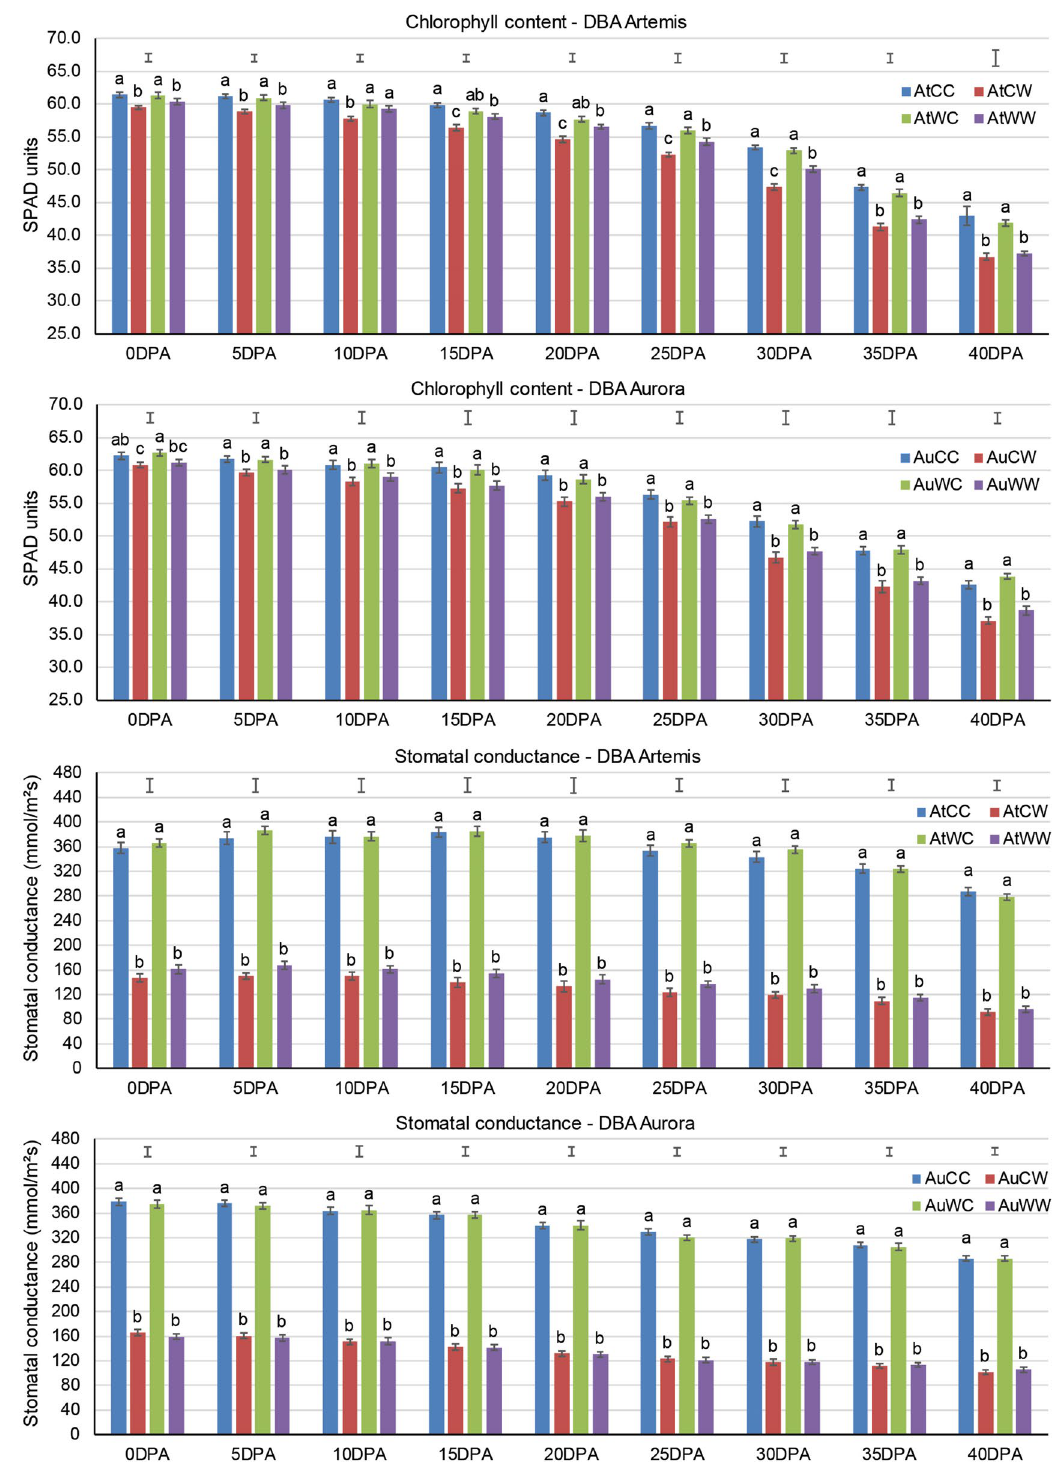
Figure 1. Effects of transgenerational water stress on chlorophyll content and stomatal conductance measured on the flag leaf every 5 days from flowering to 40 DPA (days post anthesis) in two durum wheat genotypes. Means ± SE for n = 8 are shown for chlorophyll content and means ± SE for n = 4 are shown for stomatal conductance. Different letters ( a – c ) denote statistically significant differences at the P < 0.05 level among treatment groups within a time-point. Capped lines show the l.s.d. values at P = 0.05 for comparison among treatment groups at each time-point. The treatment groups are: AtCC (DBA Artemis control group parents, progeny treated with control), AtCW (DBA Artemis control group parents, progeny treated with water-deficit stress), AtWC (DBA Artemis water-deficit stress group parents, progeny treated with control), AtWW (DBA Artemis water-deficit stress group parents, progeny treated with water-deficit stress); AuCC (DBA Aurora control group parents, progeny treated with control), AuCW (DBA Aurora control group parents, progeny treated with water-deficit stress), AuWC (DBA Aurora water-deficit stress group parents, progeny treated with control), AuWW (DBA Aurora water-deficit stress group parents, progeny treated with water-deficit